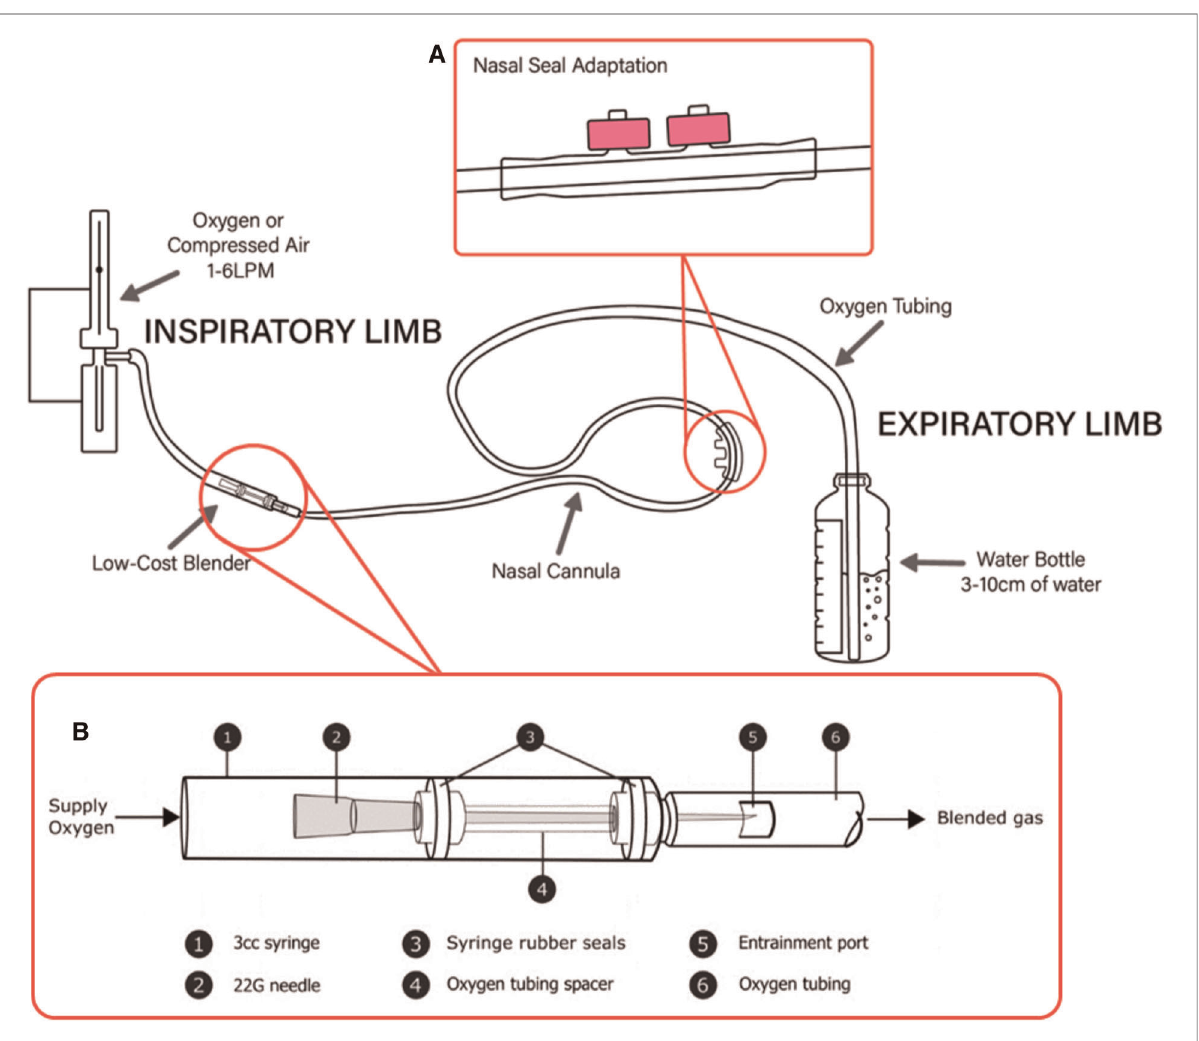
TABLE 2 The BCPAP score for effectiveness of bubble CPAP delivery.